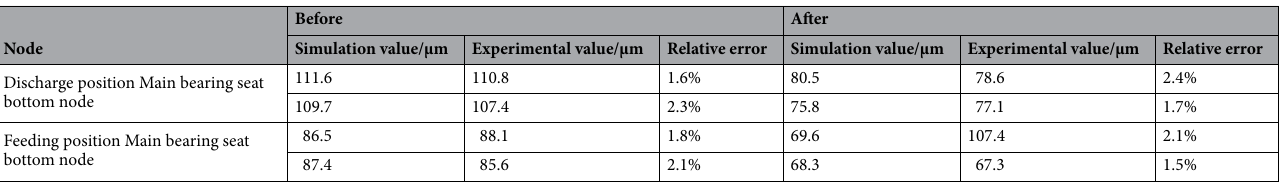
Table 4. Simulation and test